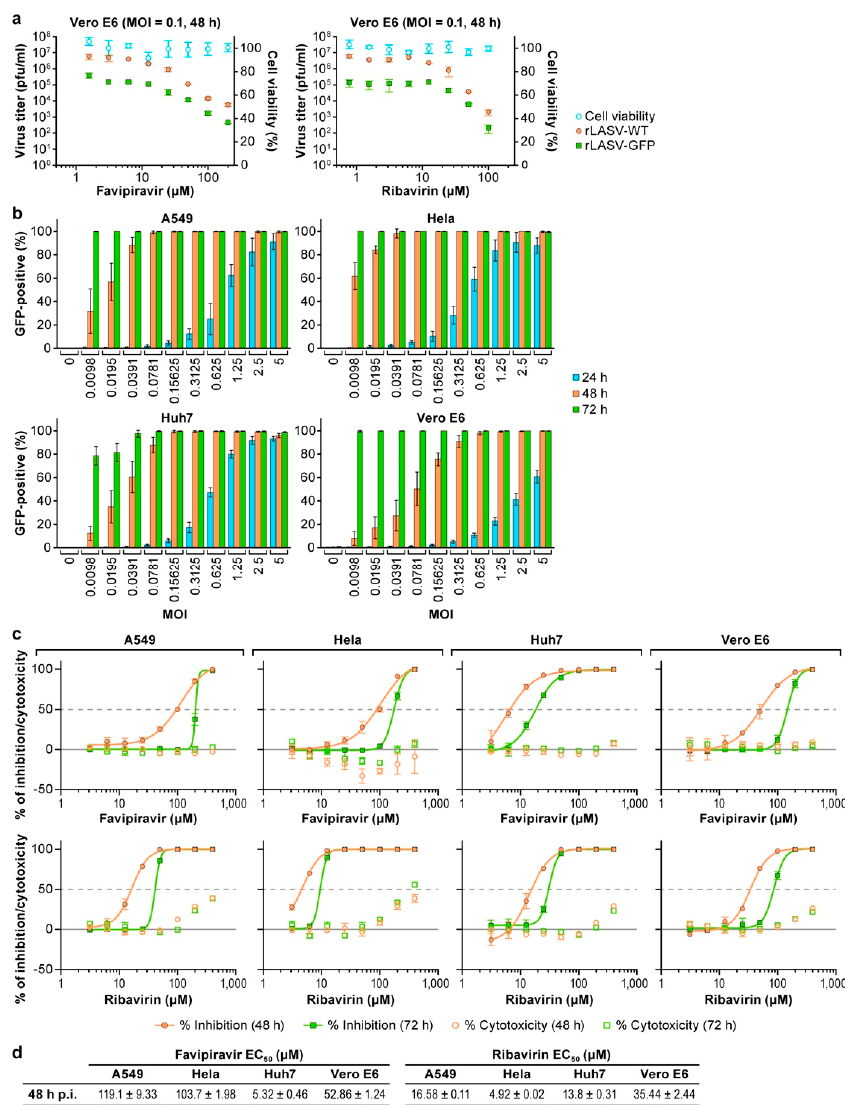
Figure 4. Antiviral drug evaluation based on recombinant LASV expressing GFP (rLASV-GFP). ( a ) Vero E6 cells were pretreated with drugs at the indicated concentrations and then exposed to rLASV-WT or rLASV-GFP (MOI = 0.1) in the presence of the drugs. Viral titers in TCS at 48 h PI were determined